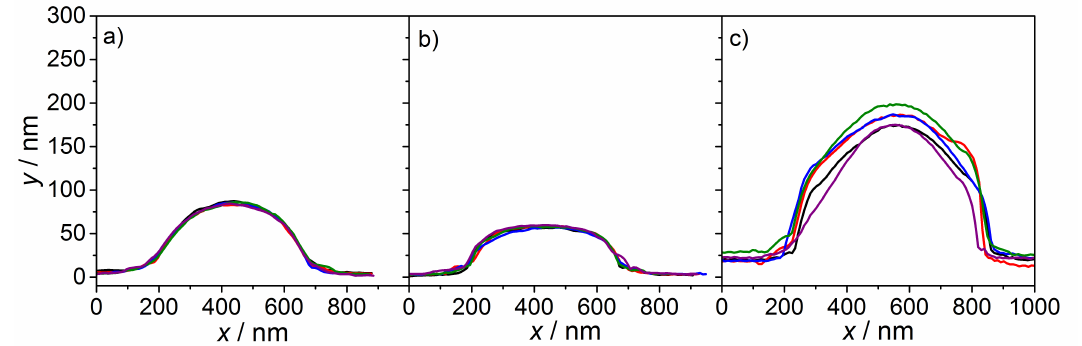
Figure 3. From left to right: height profiles of ( a ) NNPAM, ( b ) NIPAM and ( c ) NIPMAM homopolymer microgels obtained from AFM measurements in tapping mode. Each line represents one microgel particle of the same sample. The samples are characterized in the dried state.